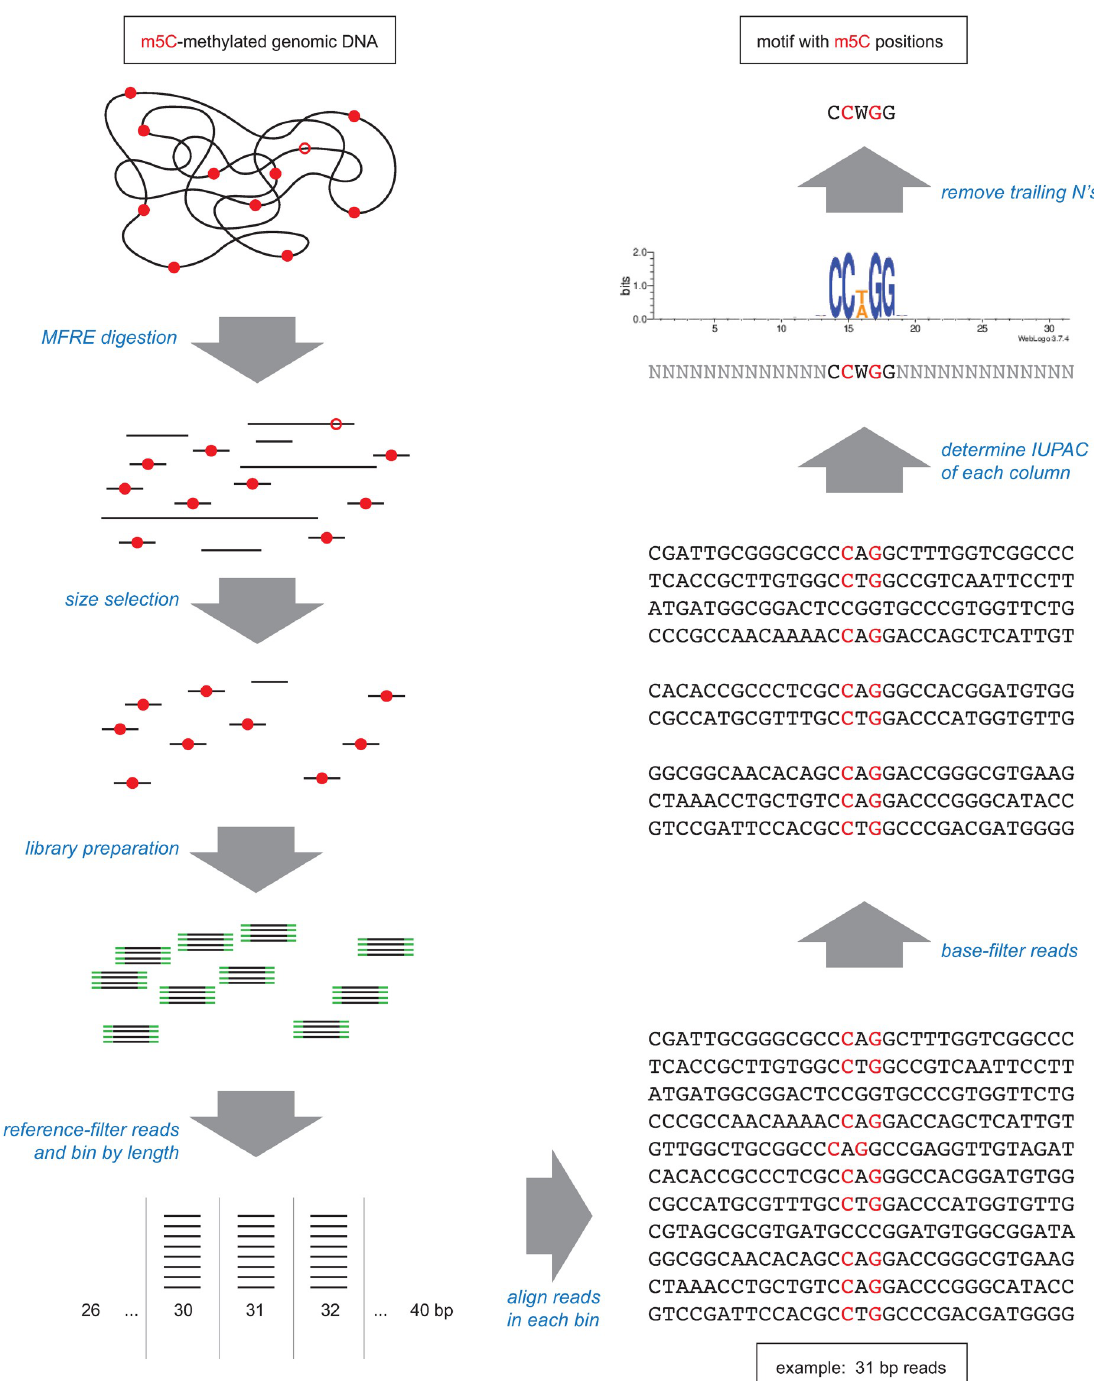
Fig 2. Overview of MFRE-Seq. Genomic DNA containing motifs that are fully methylated (red dots) or hemi-methylated (open red circles) is digested with one or more MFREs. Size selection enriches for the small fragments that result from MFRE cleavage of fully methylated sites, and sequencing libraries are prepared from these fragments (adapters in green). Sequence reads are then mined for motifs. The computational method for doing so described in this work involves binning reads by length, enriching for CCRM reads by base-filtering, aligning, and examining the base distribution at each position. Base distributions can also be represented as a sequence logo, as shown here.